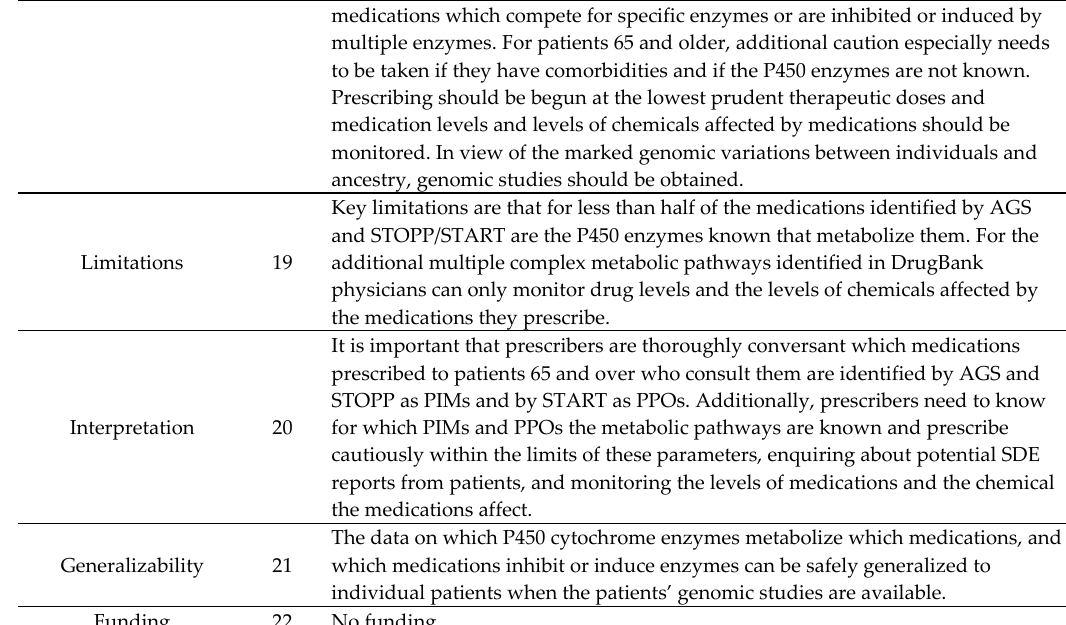
Figure 1. Strengthening the Reporting of Observational Studies in Epidemiology (STROBE) statement—Checklist of items that should be included in the reports of cross-sectional studies .